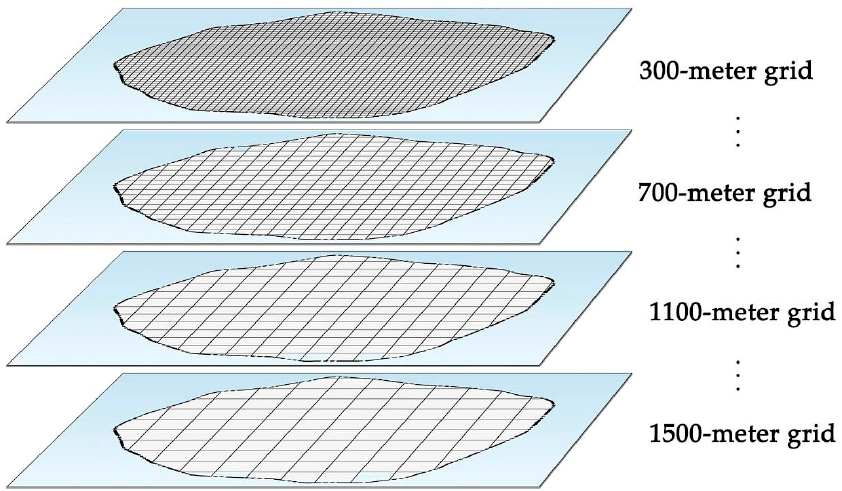
Figure 2. The schematic diagram of space unit division.